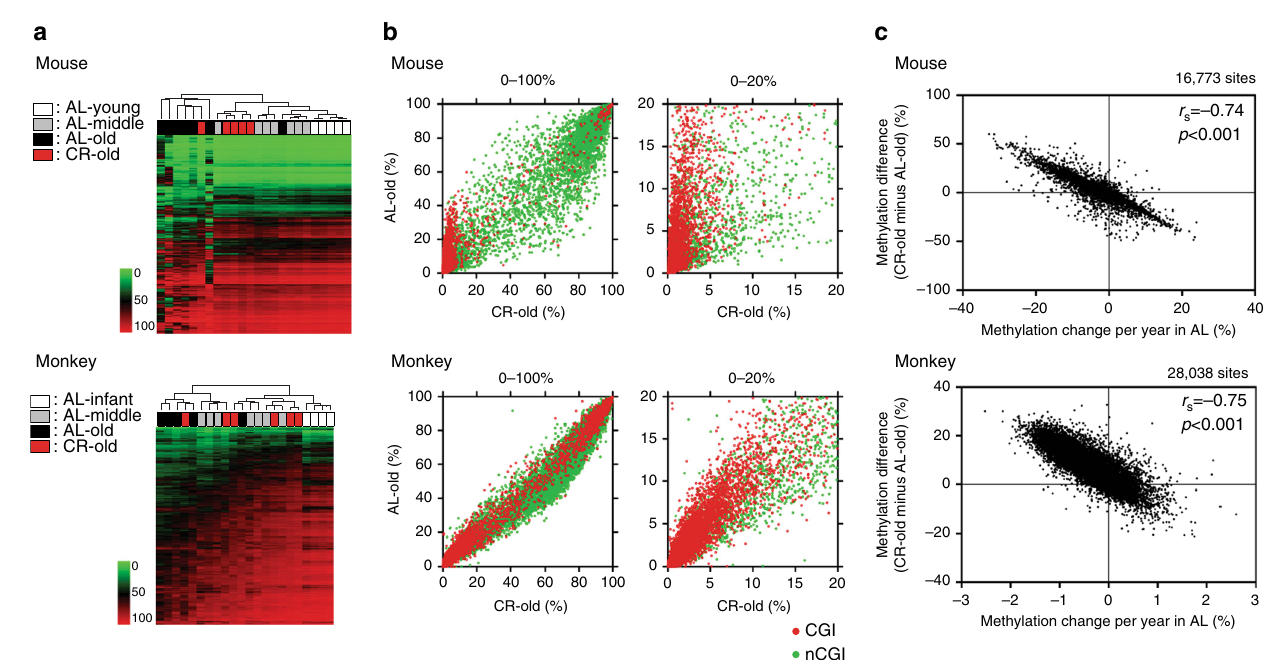
Fig. 4 DREAM analysis in CR animals. a Unsupervised hierarchical clustering analysis of methylation values in all genomic regions. The green to red scale indicates the methylation percentage. The color codes for age and caloric status are shown on the left . b DNA methylation in AL old animals vs. CR old animals. Average DNA methylation level of each CpG site in CR old individuals ( x axis), methylation in AL old individuals is shown on the y axis. The red and green dots represent CpG sites within CGI and non-CGI, respectively. The full range (0 – 100%) of methylation level is shown on the left and the low range (0 – 20%) is magni fi ed and shown on the right . c Correlation between the effects of CR and age-related methylation drift in AL animals. The x axis shows methylation changes per year in AL-fed animals. Positive/negative value means methylation increase/decrease with age, respectively. The y axis shows the differences of methylation percentage between CR old and AL old animals. Each dot represents a CpG site. Spearman r values and the corresponding two- tailed p -values were representing methylation drift per year in each species (Supple- mentary Table 17). The drift rates (mean ± SEM) were 4.1 ± 1.2% per year in mice, 0.34 ± 0.14% per year in monkeys, and 0.10 ± 0.02% per year in humans (Fig. 3a). Methylation drift